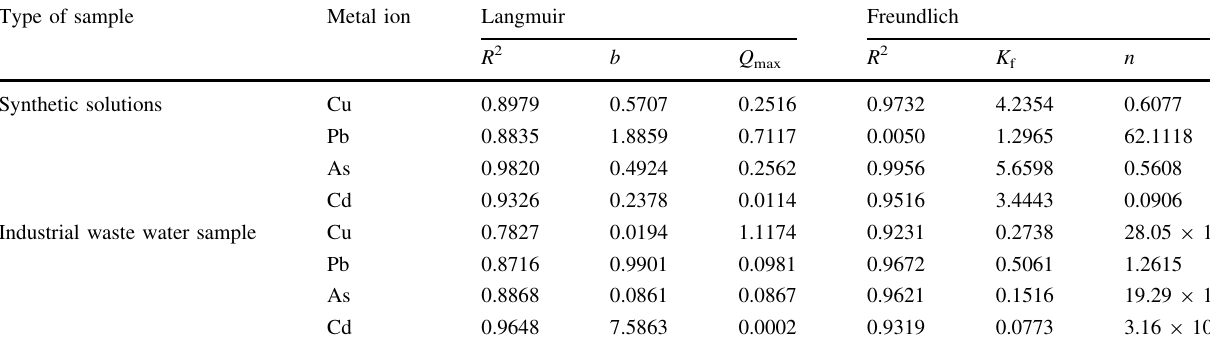
Fig. 6 Comparison of heavy metals removal (%) in industrial wastewater and synthetic solution. a Cu, b Pb, c As, d Cd Table 5 Isotherm constants for sample adsorption of different heavy metals Type of